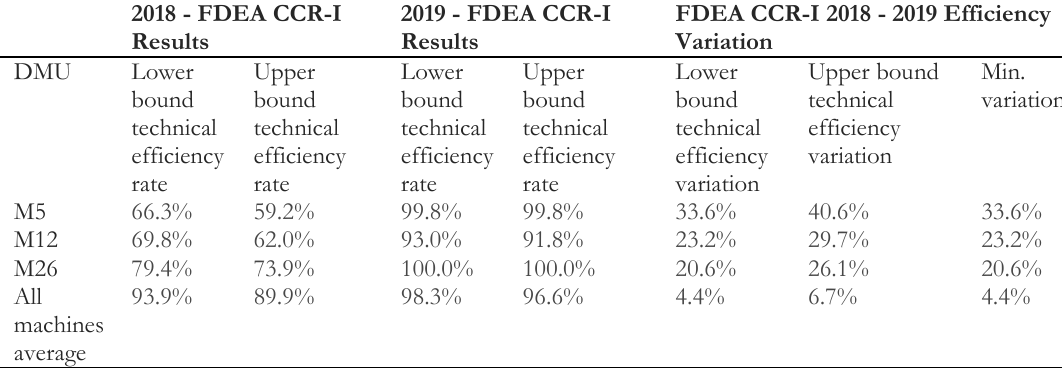
Table 6. CCR – input-oriented FDEA results and efficiency